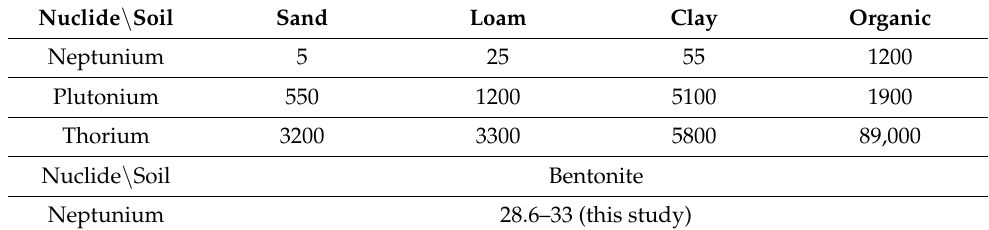
Table 12. Comparison of the Kd values (cm 3 /g) estimated in the literature and in this study. Nuclide \ Soil Sand Loam Clay Organic Neptunium 5 25 55 1200 Plutonium